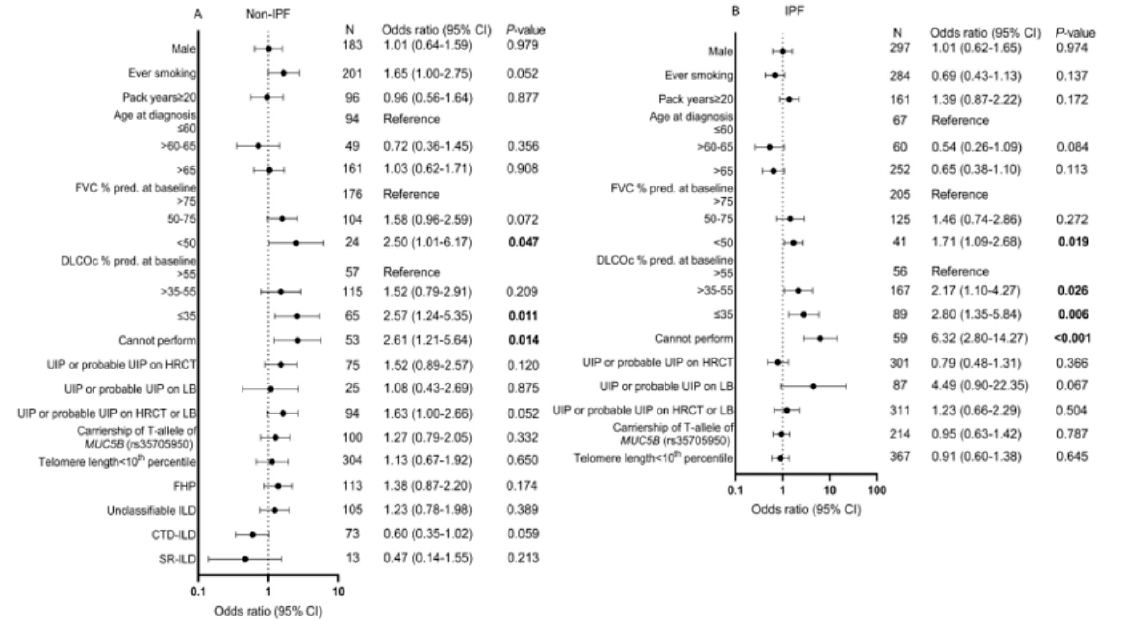
Figure 4. Odds ratio’s for PPF in ( A ) Patients diagnosed with a fibrotic ILD other than IPF and ( B ) Patients diagnosed with IPF. CI: Confidence interval, CTD-ILD: Connective tissue disease- associated interstitial lung disease, DLCOc: Diffusing capacity for carbon monoxide corrected for hemoglobin, FHP: Fibrotic hypersensitivity pneumonitis, FVC: Forced vital capacity, HRCT: High- resolution computed tomography, ILD: Interstitial lung disease, IPF: Idiopathic pulmonary fibrosis, LB: Lung biopsy, PPF: Progressive pulmonary fibrosis, SNP: Single nucleotide polymorphism, SR-ILD: Smoking-related interstitial lung disease and UIP: Usual interstitial pneumonia.